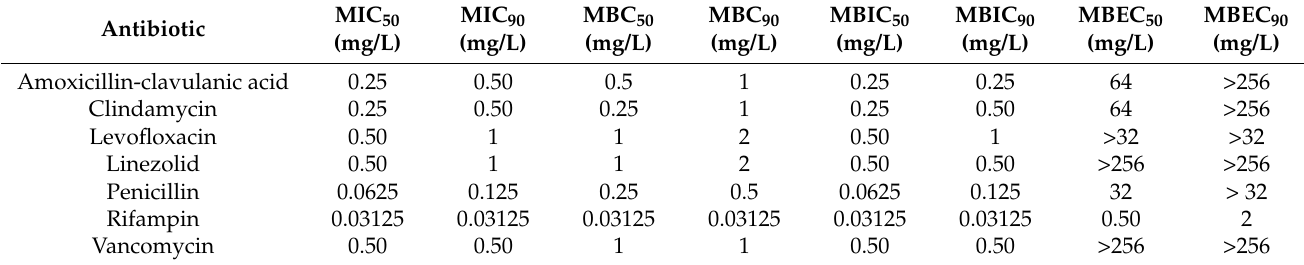
Table 2. MIC 50 , MIC 90 , MBC 50 , MBC 90 , MBIC 50 , MBIC 90 , MBEC 50 , and MBEC 90 for each Antibiotic of C. acnes Strains in